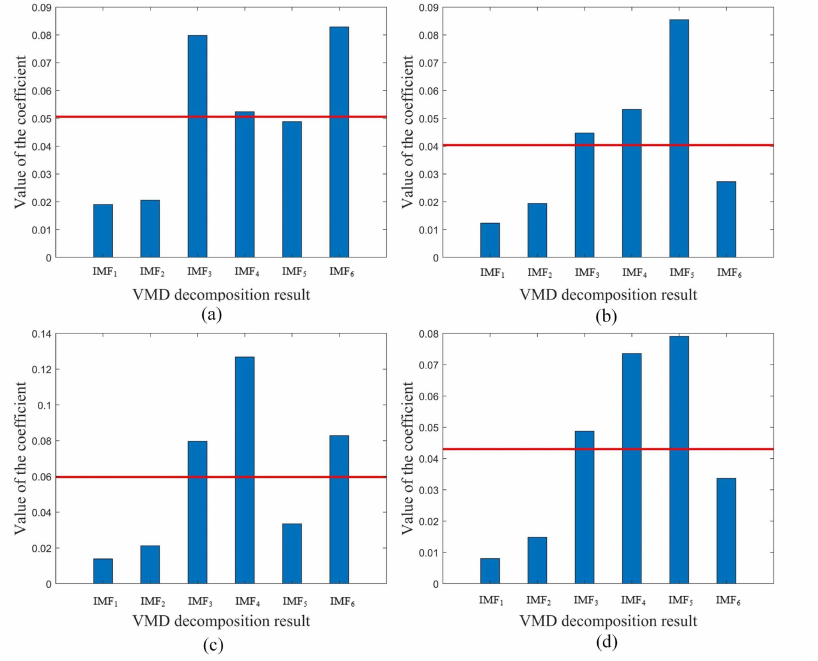
Figure 12. Evaluation results of IMF components corresponding to vibration signals of the ER-12K rolling bearing in 4 states: ( a ) Inner race fault, ( b ) Outer race fault, ( c ) Rolling element fault, ( d ) Normal